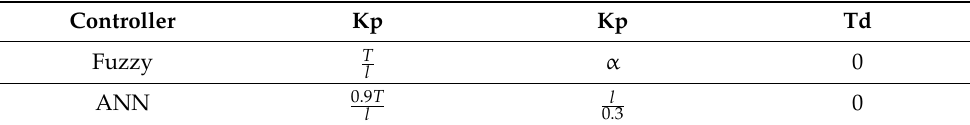
Table 1. Controller’s input and